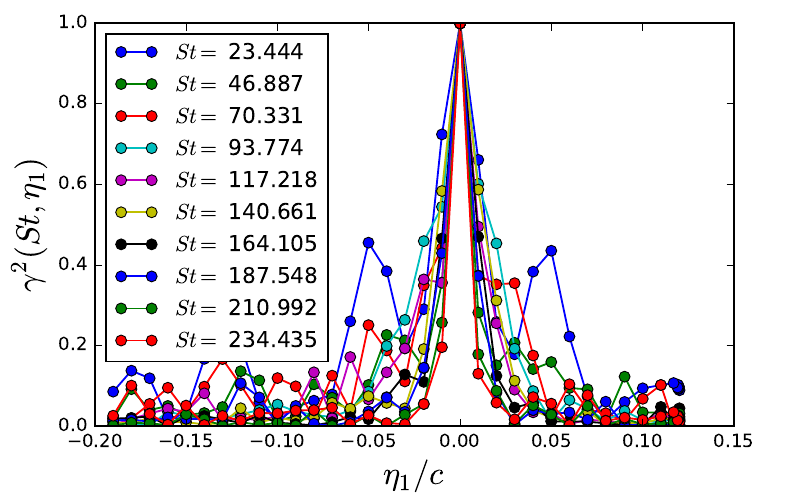
Figure 11. Wall-pressure longitudinal coherence.